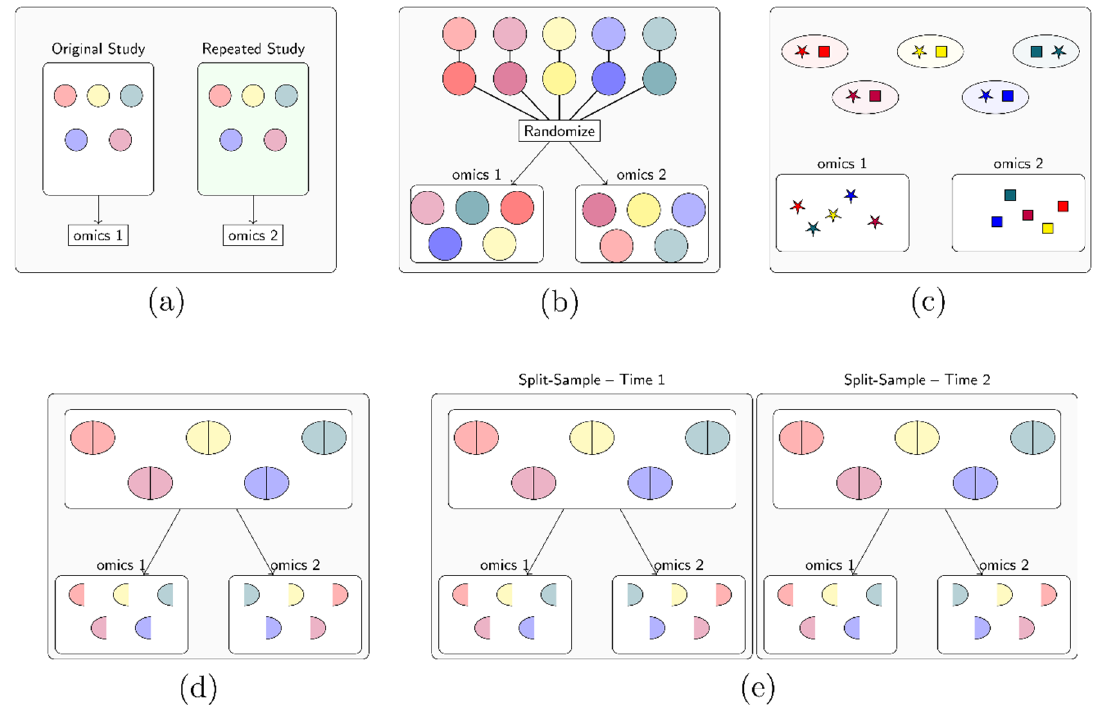
Figure 4. Common study designs in multi-omics studies. ( a ) Repeated design; ( b ) Replicate design; ( c ) Source-matched design; ( d ) Split-sample design; ( e ) Longitudinal split-sample design.